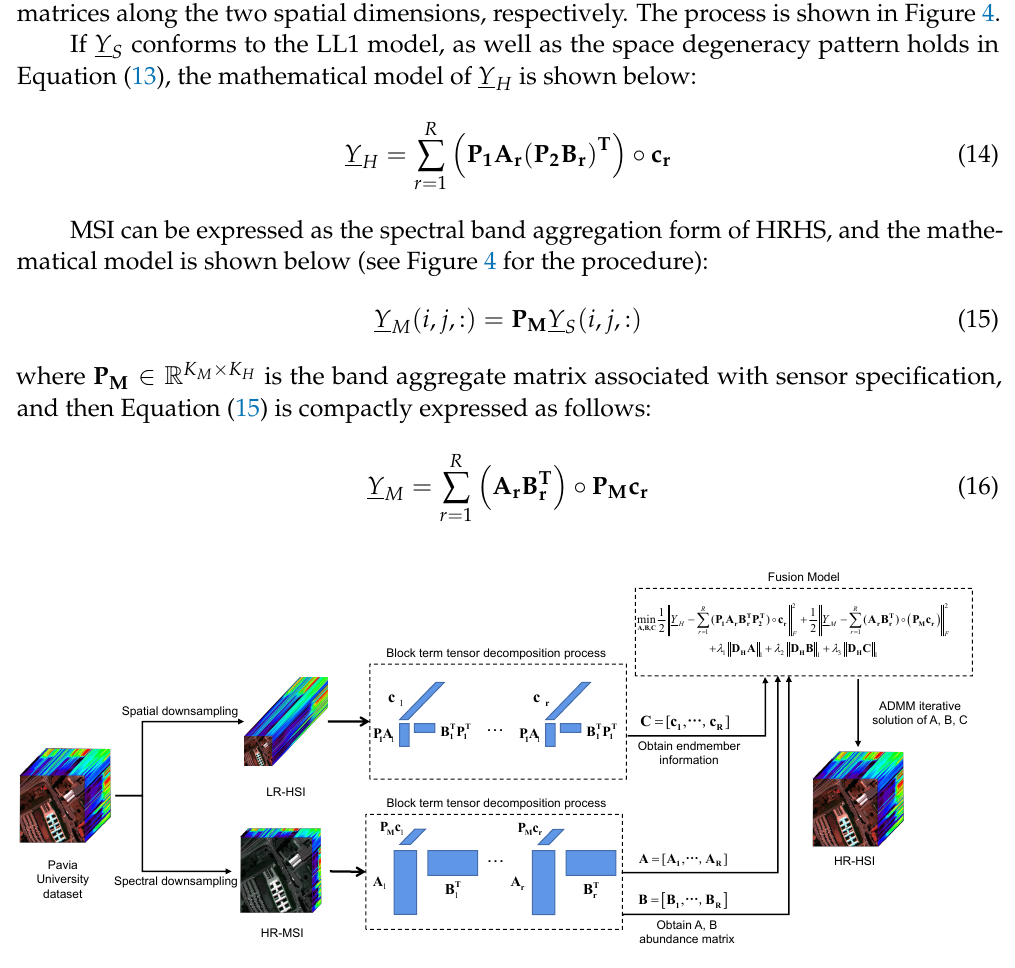
Figure 4. The flow chart of the algorithm in this